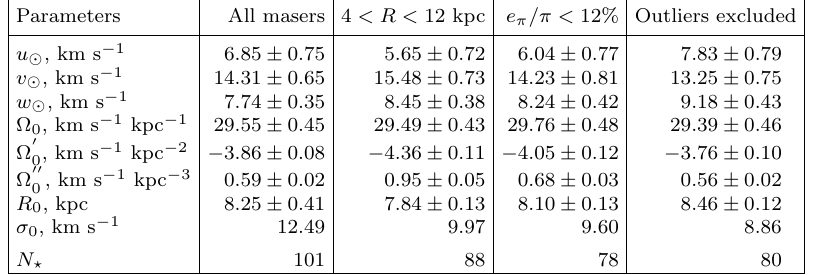
Table 1. Kinematic parameters inferred from an analysis of the three-dimensional velocity field.